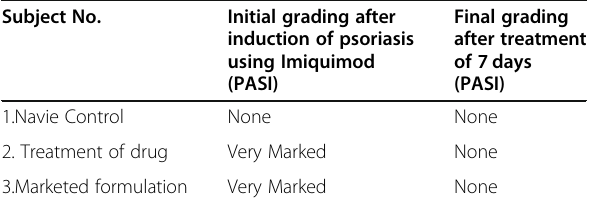
Table 1 PASI grading of psoriasis animal before and